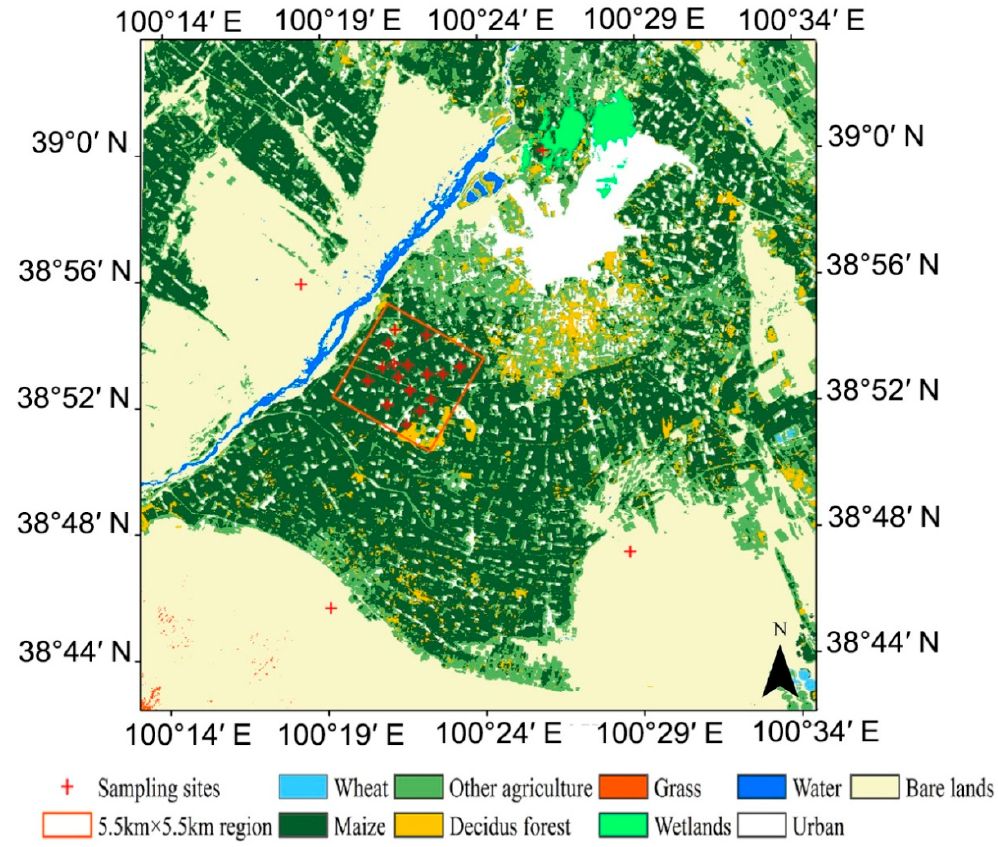
Figure 2. Location of field sampling sites. Twenty-one field observation sites distributed in the 30 km × 30 km region, among which 17 field observation sites are in the core 5.5 km × 5.5 km region.